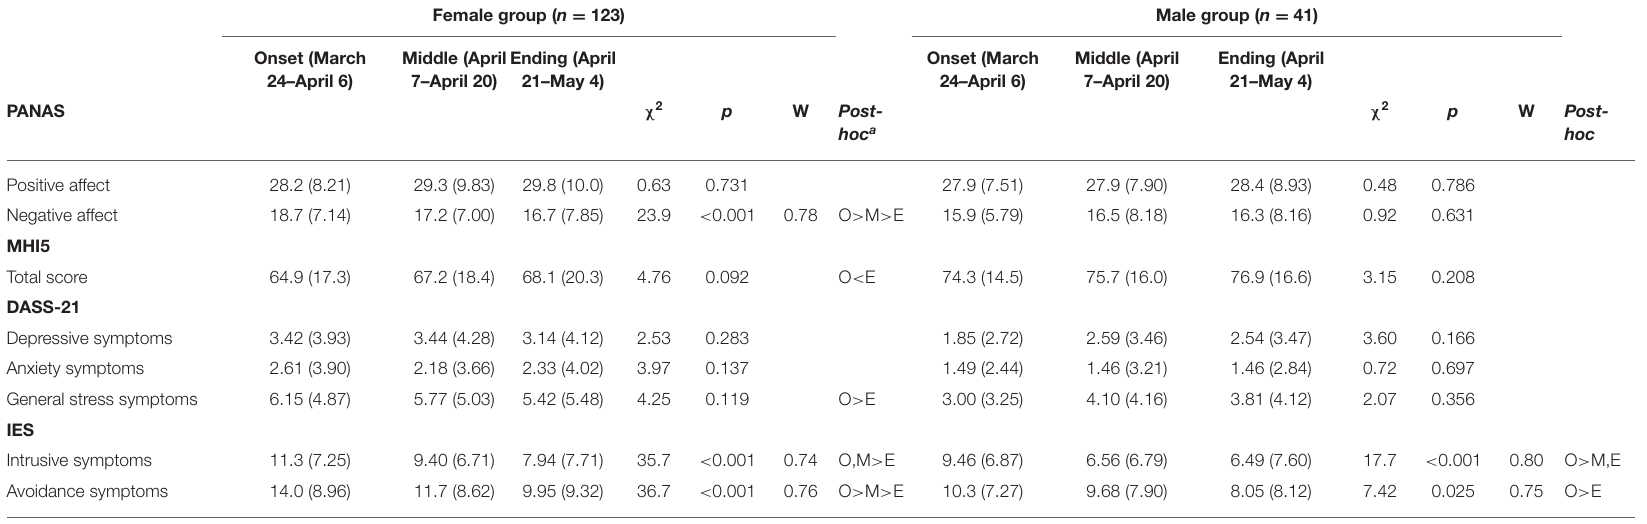
TABLE 4 | Within-group comparisons by gender of the psychological